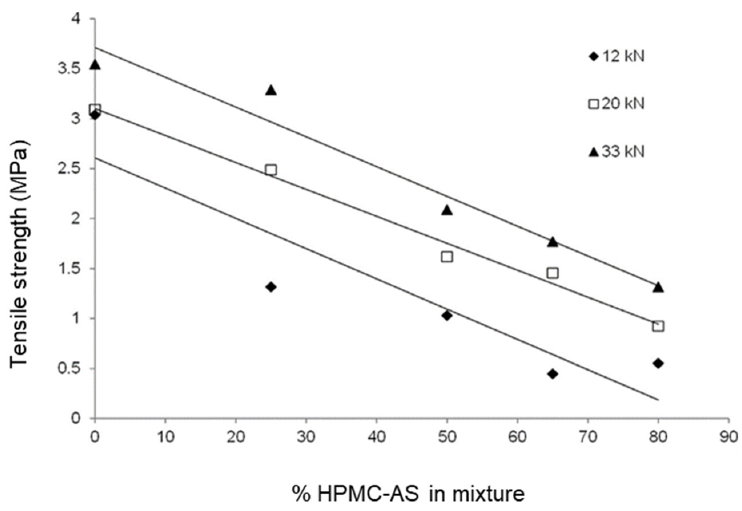
Figure 16. Tensile strength of ASD tablets composed of mixtures of milled extrudate of HPMC-AS and copovidone at compression forces of 12, 20 and 33 kN. Adapted with permission from [154]